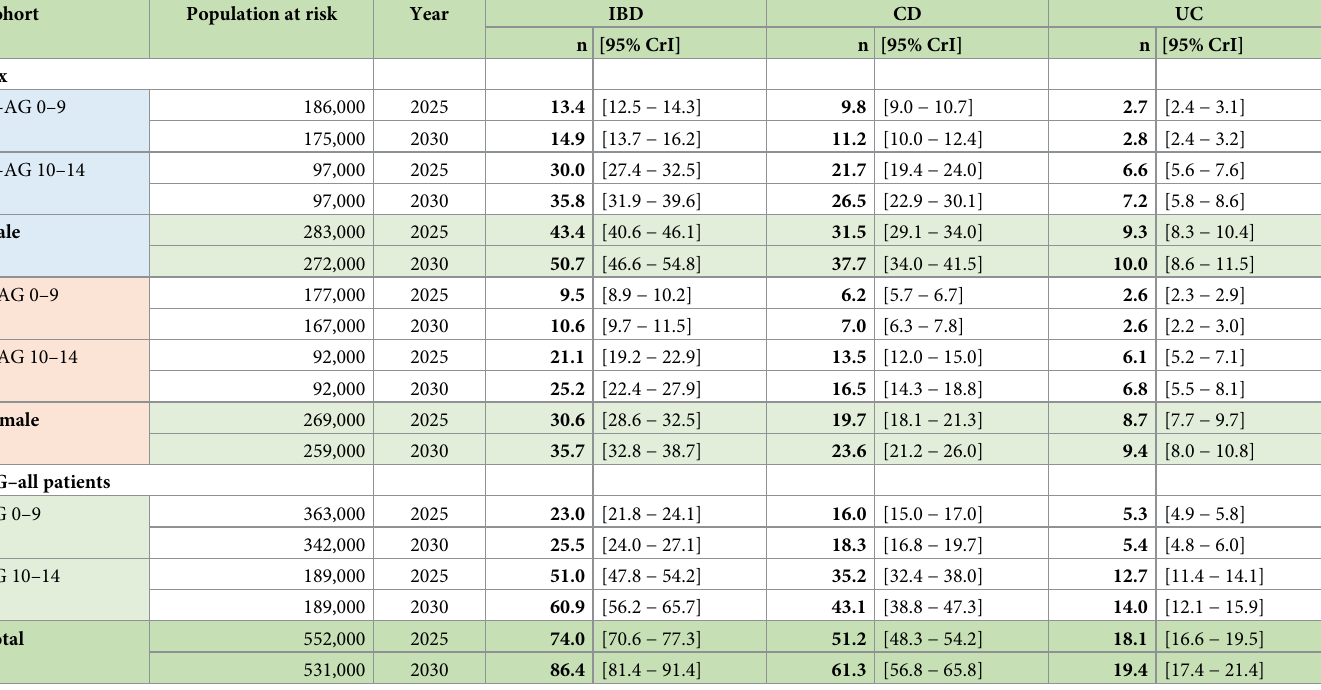
Table 5. Projected number of children and adolescents < 15 years of age at diagnosis with inflammatory bowel disease (IBD), Crohn’s disease (CD) und ulcerative colitis (UC) in Saxony to the years 2025 and 2030 (and by age and sex).